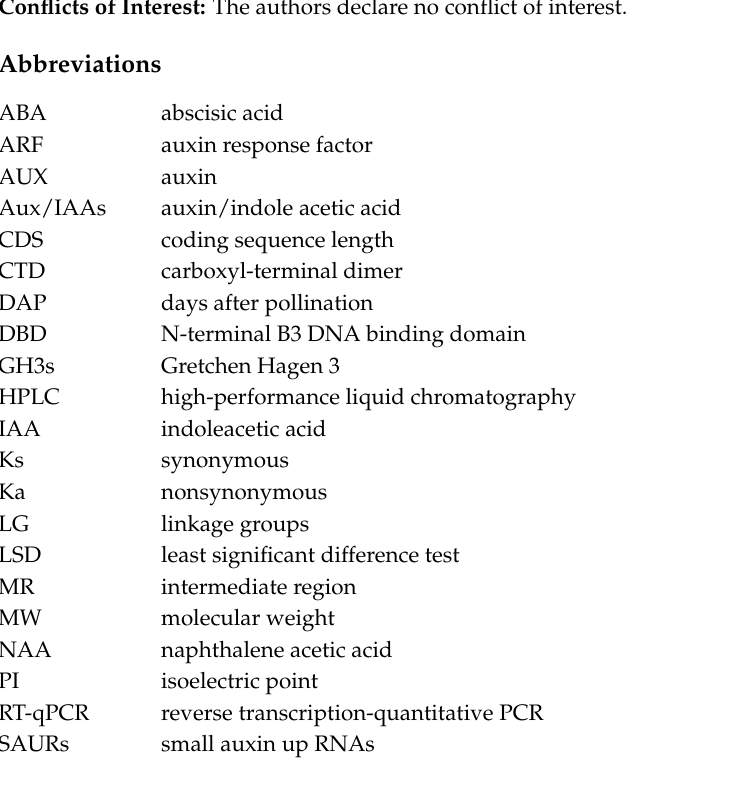
s1, Figure S1: Alignment of multiple FtARF and selected ARF domain amino acid sequences, Table S1: List of the 20 FtARF genes identified in this study, Table S2: Analysis and distribution of conserved motifs in tartary buckwheat ARF proteins, Table S3: One-to-one orthologous relationships between tartary buckwheat and other seven plant species, Table S4: Primers of